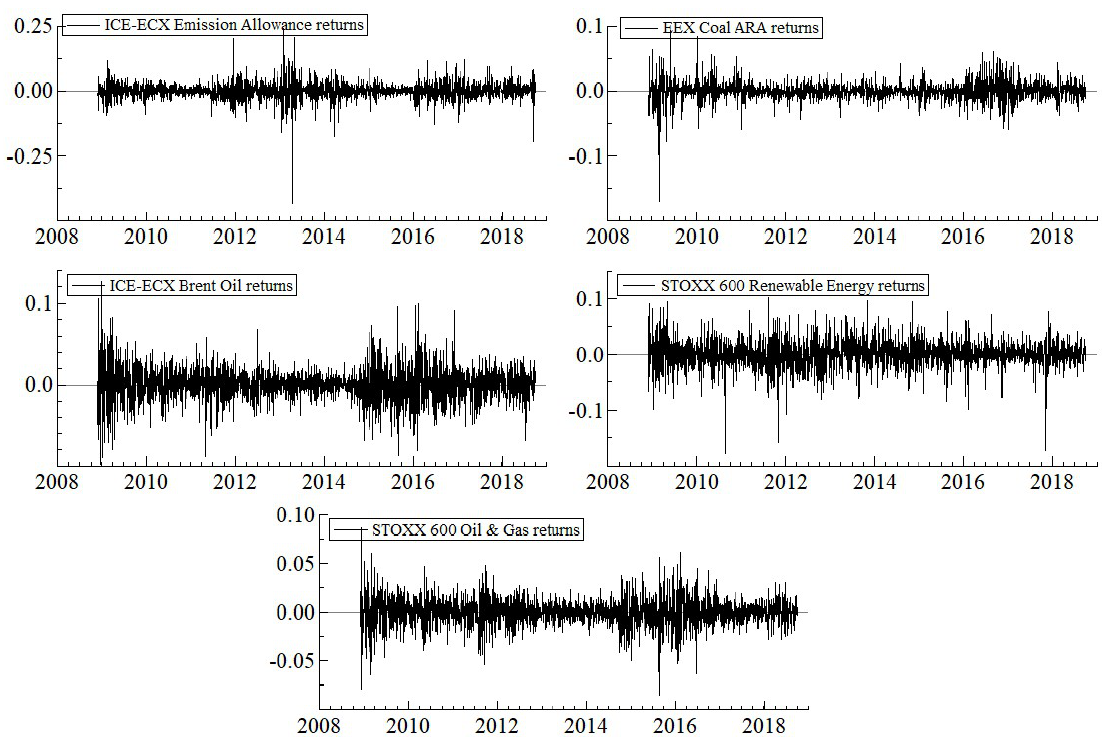
Figure 2. Returns, 2 December 2008 to 28 September 2018.